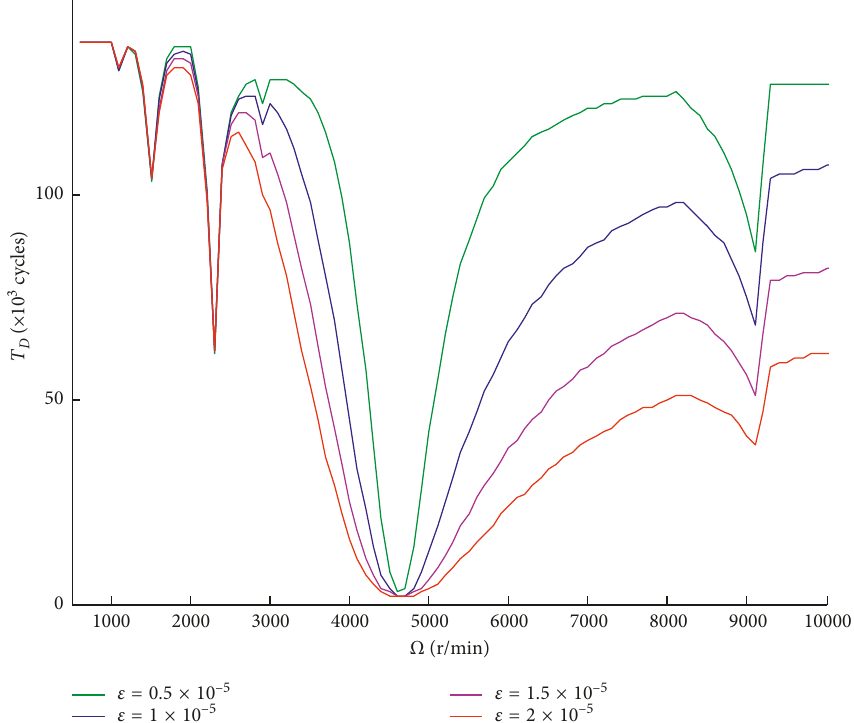
Figure 12: Fatigue degradation life versus rotation speed for various eccentricities with β